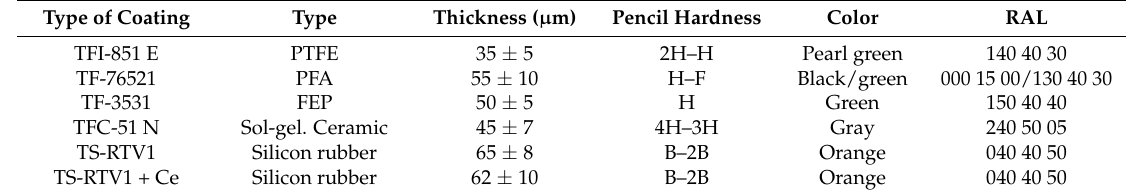
Table 1. Non-stick coatings on aluminum plates used in cycles of forming of PUR foam. Type of